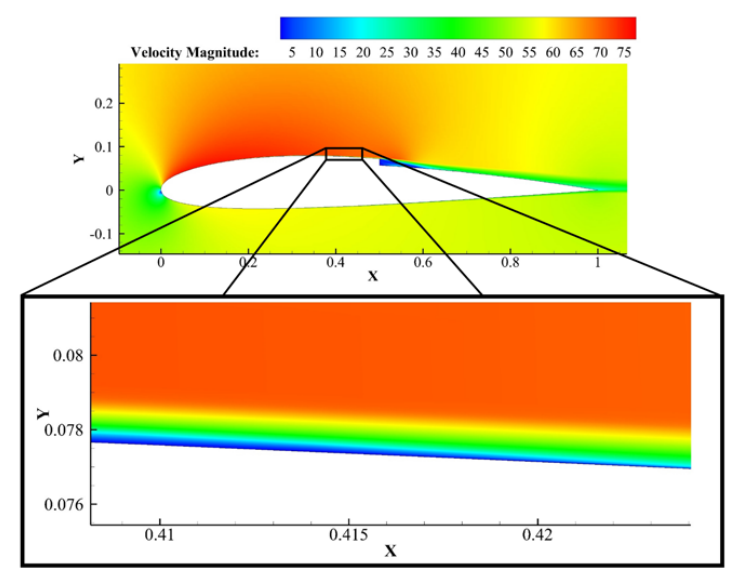
Figure 10. Velocity contour plot showing a close-up on the location of transition of the viscous boundary layer from laminar to turbulent ( Re = 5.9 × 10 6 , α = 2.5 ◦ and step located at X U / C = 0.5).